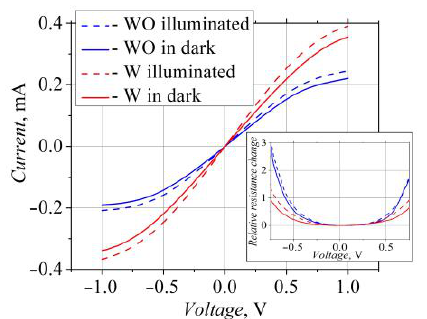
Figure 2. Current – voltage characteristics of the bow-tie diodes in the dark (solid lines) and under illumination (dashed lines, illuminance 14,400 lx.). In the inset: dependences of the relative resistance change on applied voltage.